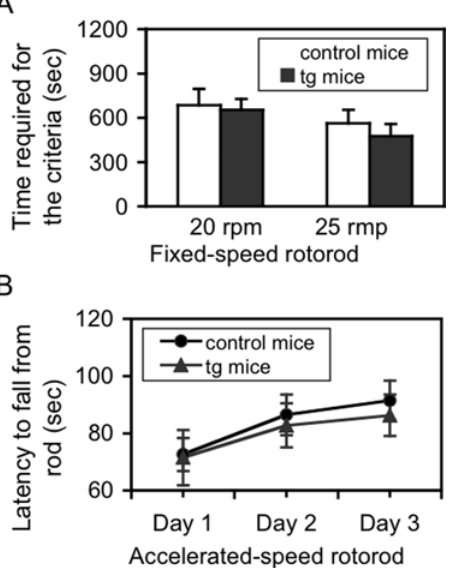
Figure 5. Effects of the NR2B transgene on motor learning under the standard housing condition. A. Motor learning in fixed- speed rotorod test. Two speeds, 20 rpm and 25 rpm, were used. Although a tendency of less total time required to reach the learned criterion is shown in tg mice (n=8), this tendency does not reach statistical significance, when compared to control mice (n=11) either in 20 rpm or 25 rpm fixed-speed test. B. Motor learning in an accelerated- speed rotorod test. The performance in both control (n=10) and tg (n=9) mice is better following trials and one-way ANOVA analysis reveals a significant difference in either control [F(2,27)=9.98, p , 0.001] or tg mice [F(2,24)=10.23, p , 0.001]. However, no significant difference in either the learning curve or in each training session can be found between control and tg mice. Two different sets of mice were respectively used for fixed- and accelerated-speed rotorod tests. Data are expressed as mean 6 SD.